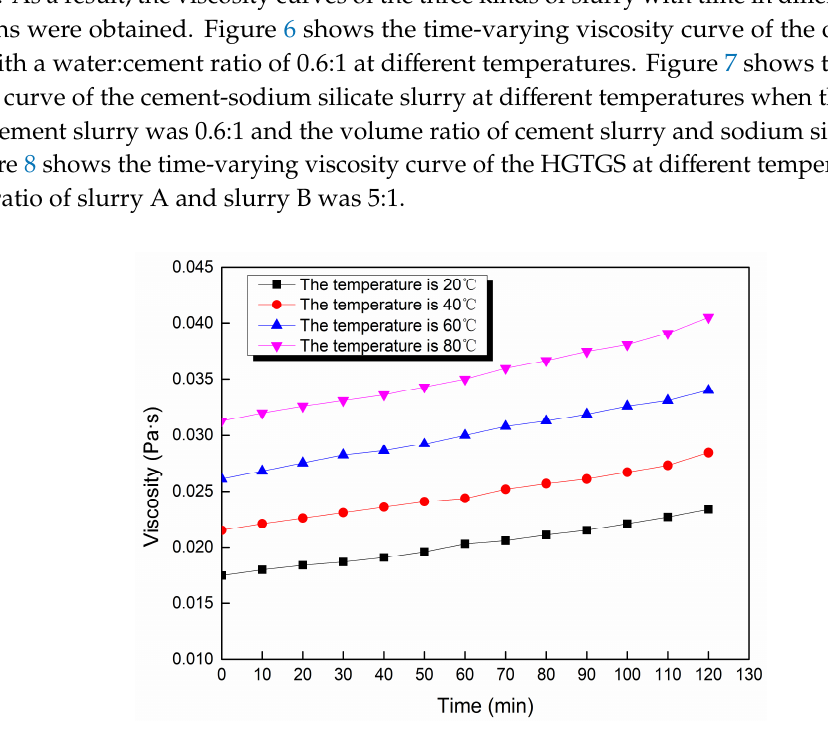
Figure 7. The time-varying viscosity curve of the cement-sodium silicate slurry at different temperatures.